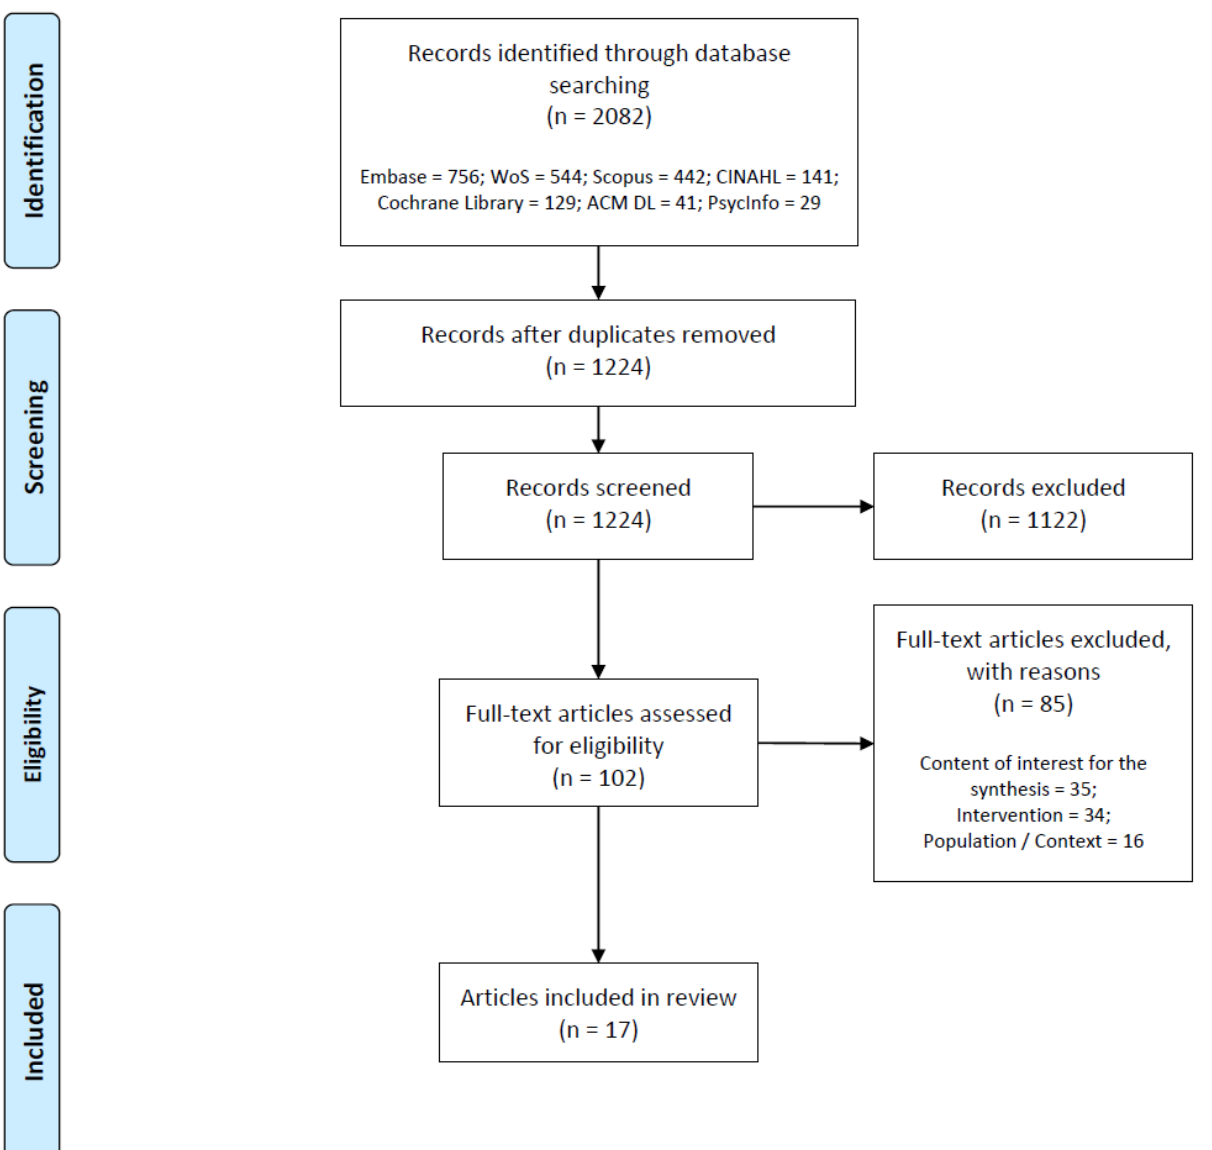
Figure 2. Flowchart of included and excluded